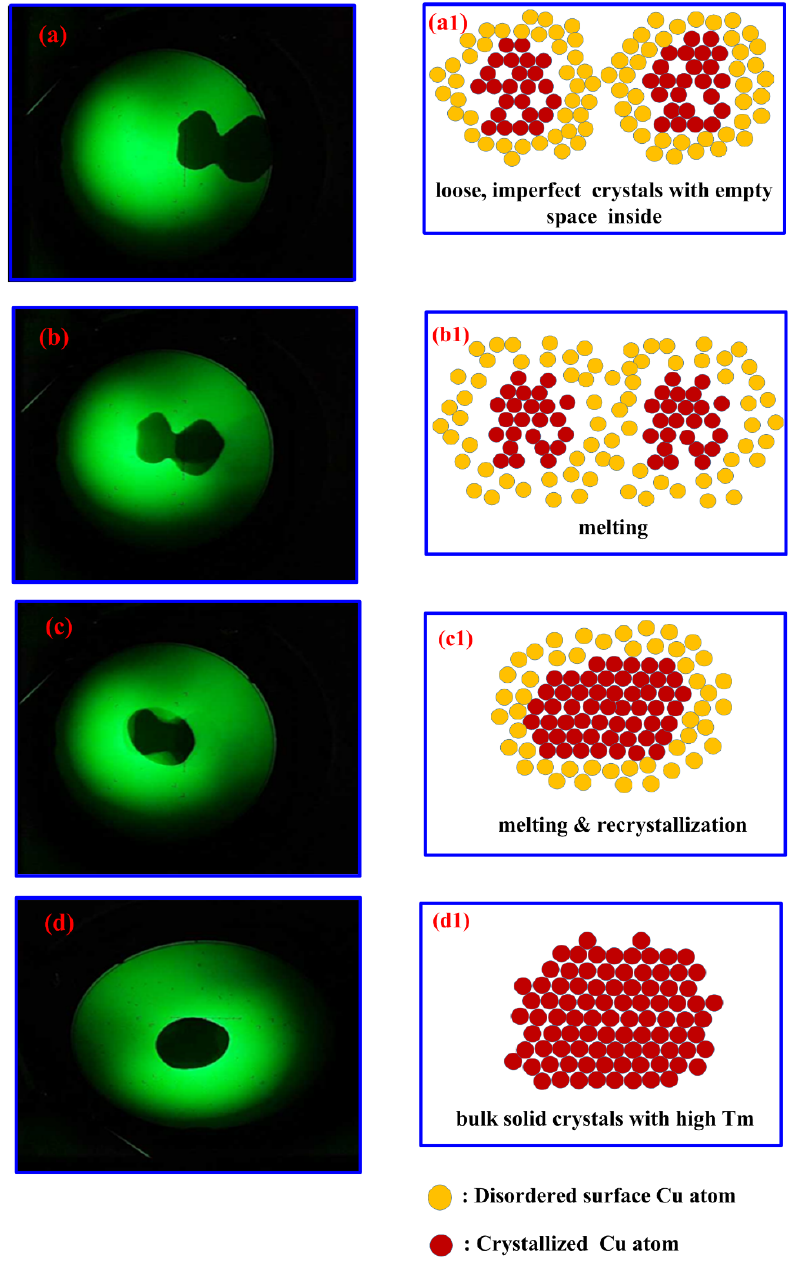
Figure 4. ( a – d ) Pictures taken directly from the monitor screen of TEM; ( a1 – d1 ) Schematic diagrams depicting the melting and recrystallization (agglomeration and impingement) of two individual particles upon exposure to TEM e-beam.